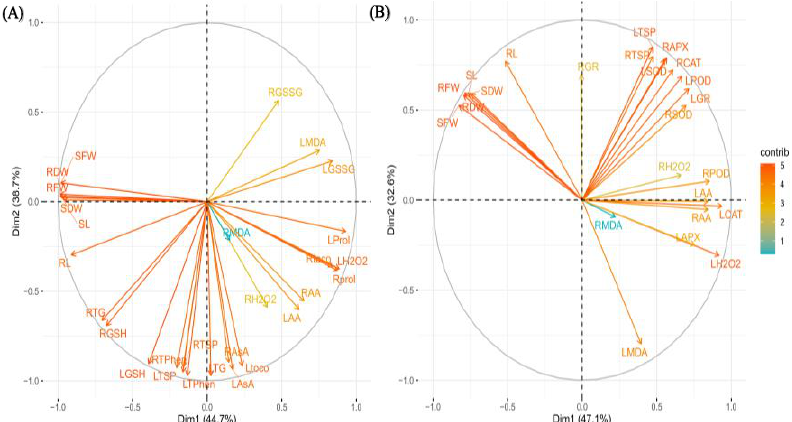
Figure 6. Principal component analysis (PCA) showing the relationship of different morphological, total soluble protein, amino acids, H 2 O 2 and MDA contents with non-enzymatic ( A ) and enzymatic ( B ) antioxidants of barley genotypes modulated by application of silicon through rooting media under salinity stress. SL: shoot length; RL: root length; SFW: shoot fresh weight; RFW: root fresh weight; SDW: shoot dry weight; RDW: root dry weight; LTSP: leaf total soluble protein; RTSP: root